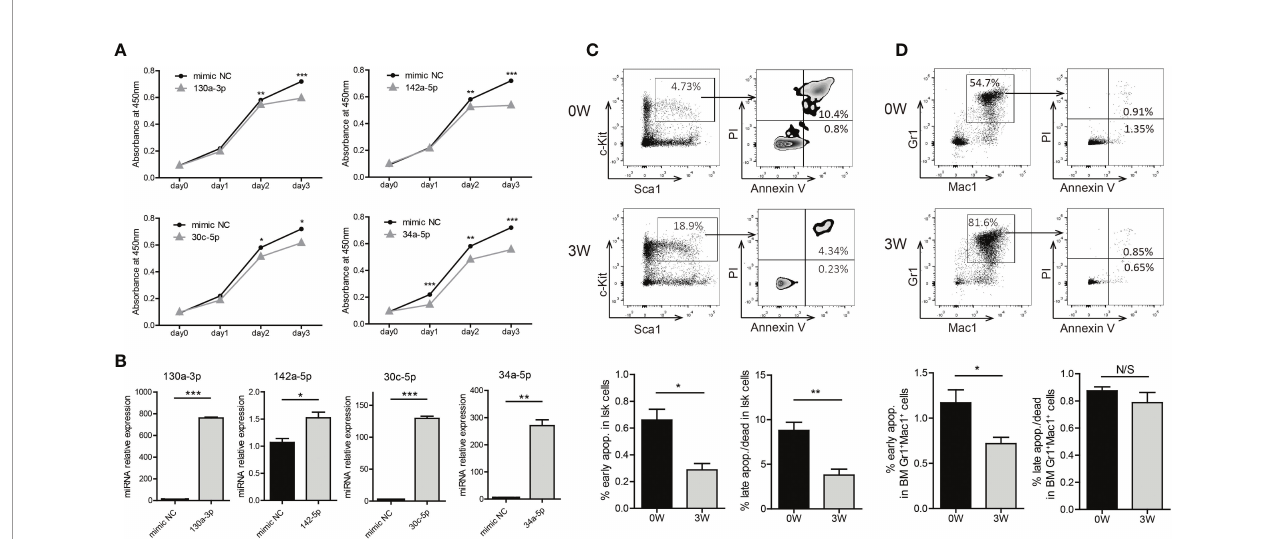
FIGURE 4 | Induction of BA expression enhanced cell survival probability of murine BM LSKs. (A) Cell viability analysis of 32D-BA cells transfected with selected miRNAs by CCK8 assays. (B) Validation of transfection ef fi ciency of miRNAs by qRT-PCR experiments. (C, D) Apoptosis analysis of BM LSKs (C) and granulocytes (D) via Annexin V/PI staining (n=3). Results are mean ± SEM, *p < 0.05, **p < 0.01, ***p < 0.001 and N/S (not signi fi cant) (A – D) was assessed by unpaired t